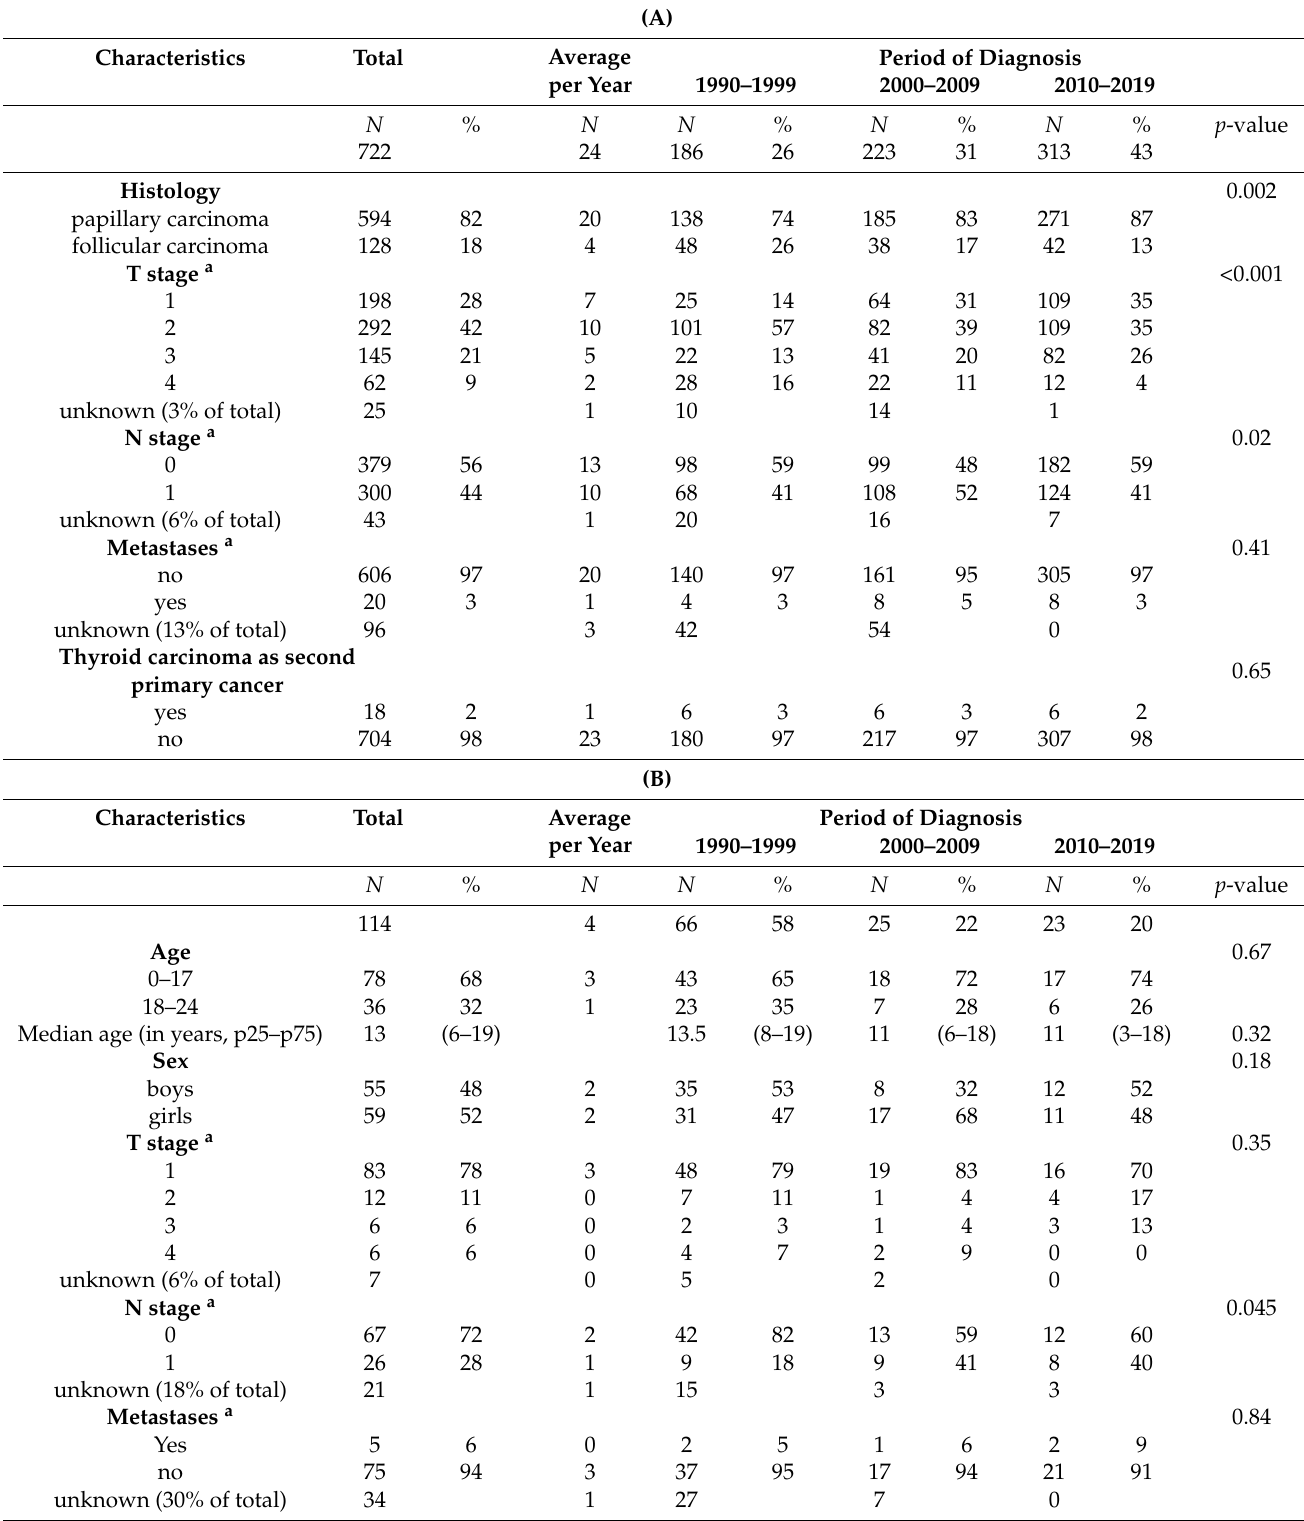
Abbreviations: N , number. Characteristics of the study population were described as percentages in relation to the three periods of diagnosis: 1990–1999, 2000–2009, and 2010–2019. Differences among categorical variables were tested with the χ 2 tests or the Monte